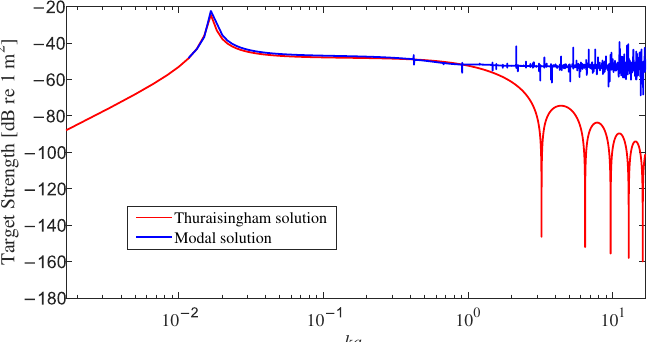
Figure 4. Comparison results of the two models for target strength calculation of a single bubble. It should be noted that multiple scattering between bubbles was ignored, and the volume backscattering strength of the bubbles was contributed by each bubble and computed using Equations (10) and